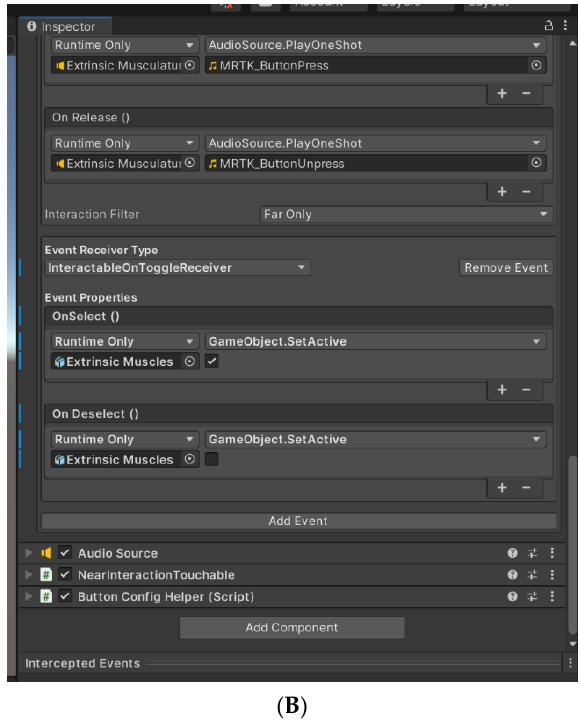
Figure 7. Muscle objects imported into Unity 3D, where UI was also developed. ( A ) Toggle switch used to selectively display the “ Extrinsic Muscles ” object. ( B ) Inspector panel for the toggle switch associated with the “ Extrinsic Muscles ” object.